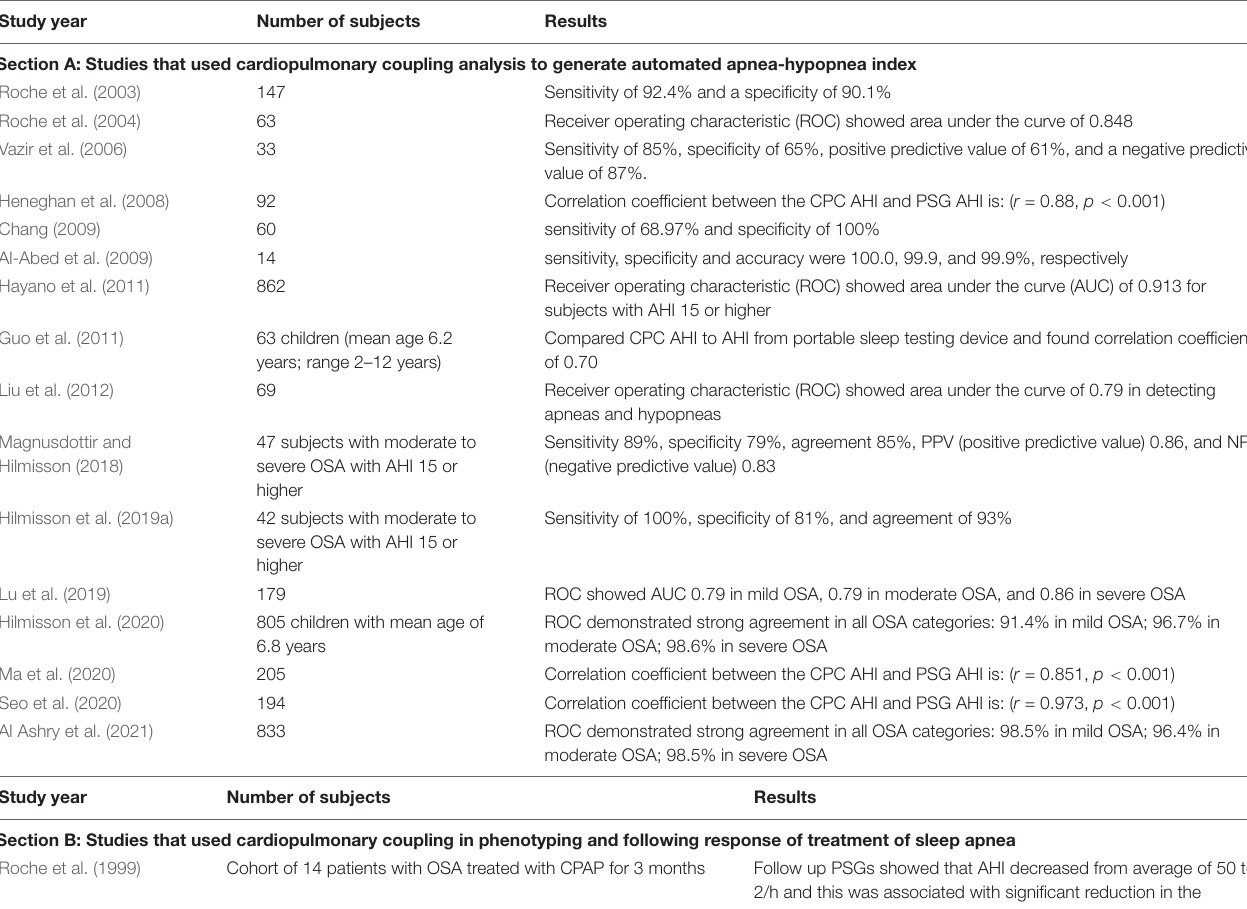
TABLE 1 | Studies that used cardiopulmonary coupling to diagnose and follow treatment response in various sleep disorders. Study year Number of subjects